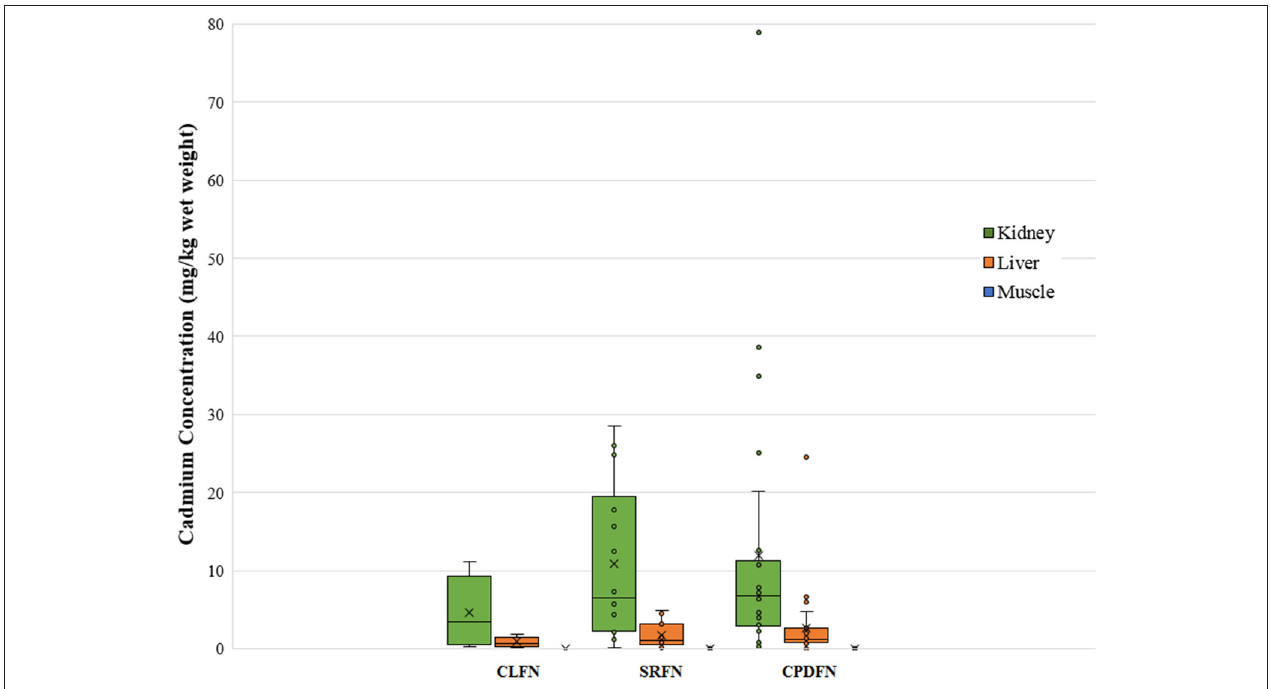
FIGURE 2 | Box plot of moose tissue